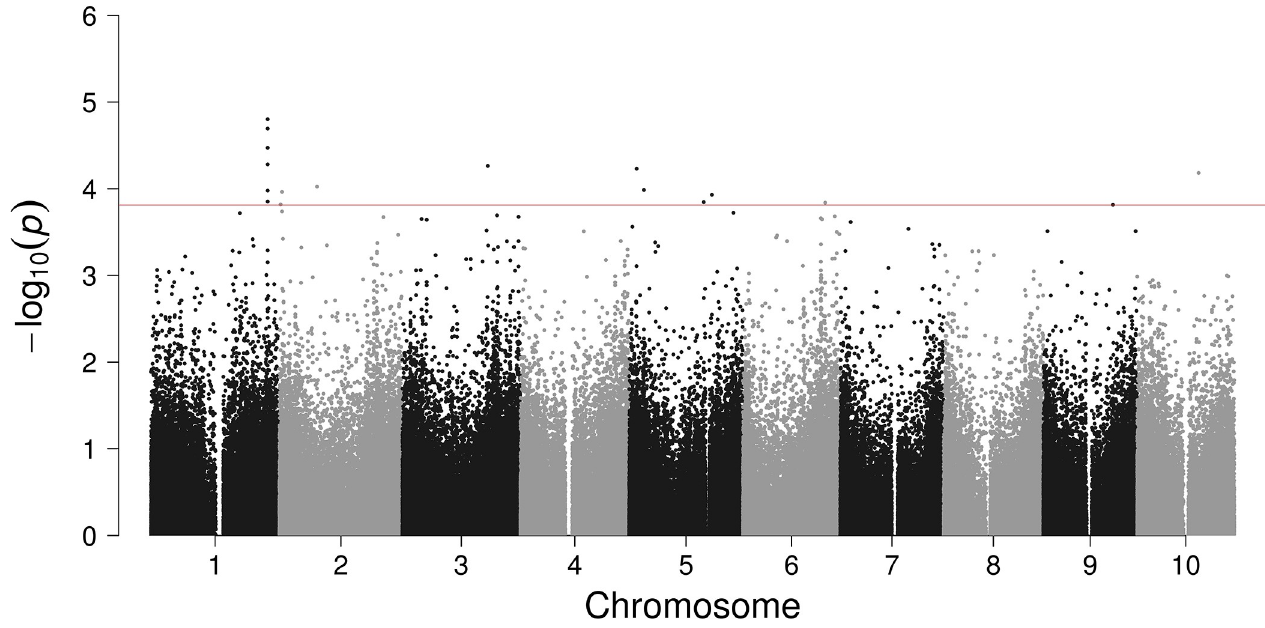
Fig 3. Genome-wide association analysis for head smut in sorghum mini core collection. Manhattan plot demonstrates the top candidate SNPs. The line is a cut-off for top candidate genes listed in Table 3.